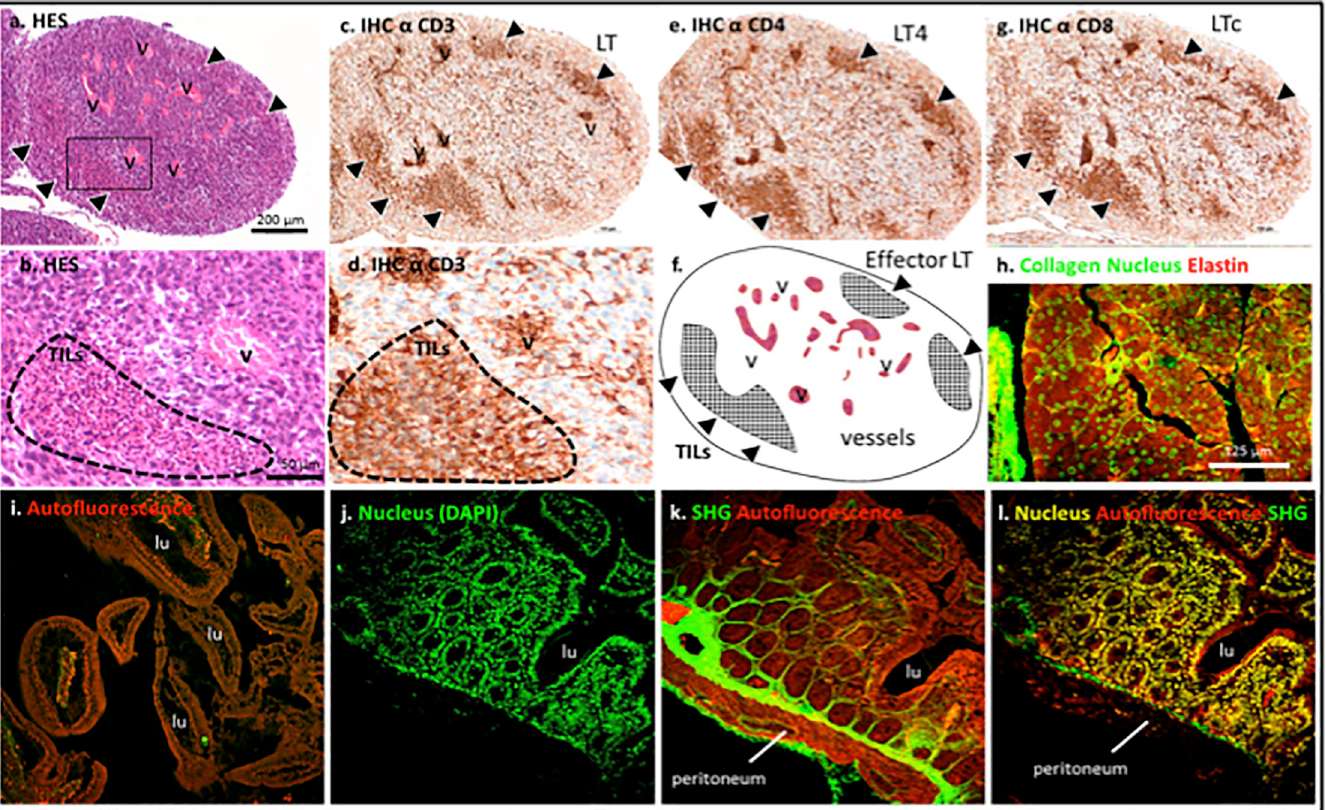
Fig 3. (A-B) HES staining and (C-G) immunohistochemistry for CD3, CD4, CD8 of a 15 days grafted CT-26+ nodule in a mouse from IP group. Grafted nodules reveal high number of cells including Tumor infiltrating Lymphocytes (TILs) among a complex tumoral microenvironment (high vascularization, poor fibrosis, dense